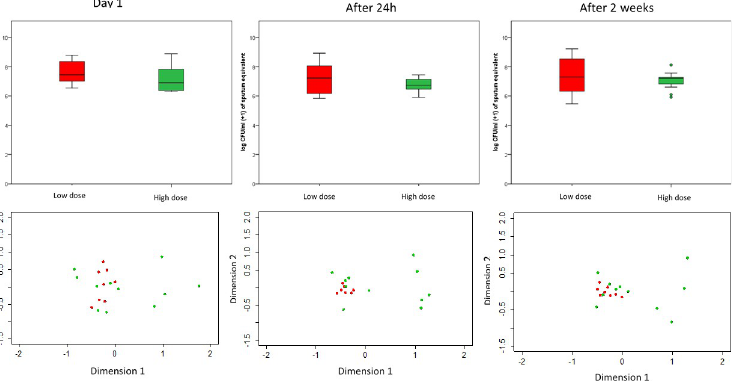
Fig 4. The NMDS (non-metric multidimensional scaling) of the microbiota composition of asthma patients (top) and total bacterial load (log CFU/ml +1) (bottom) grouped into ICS dose group of low-dose ICS (red) and high-dose ICS (green) at (a) Day 1, (b) Day 2 (after 24 h) and (c) Day 14 (after 2 weeks).